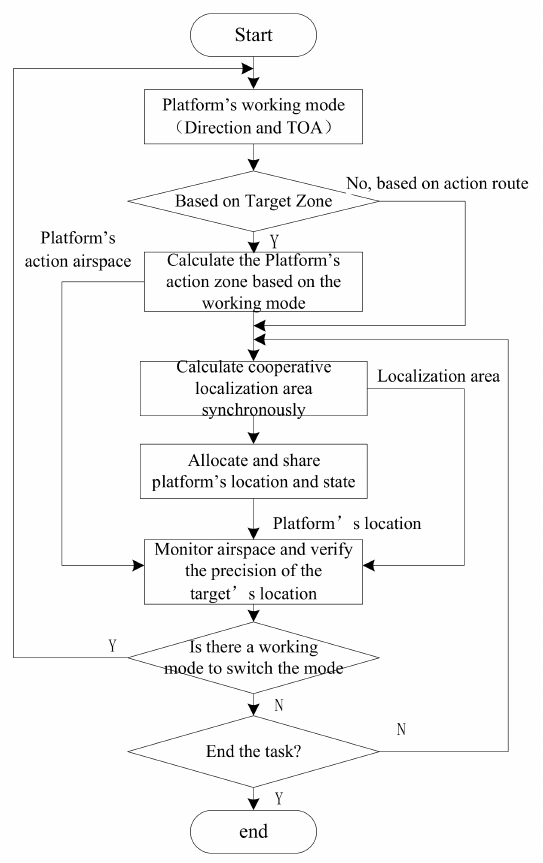
Figure 14. Experimental flow chart of cooperative